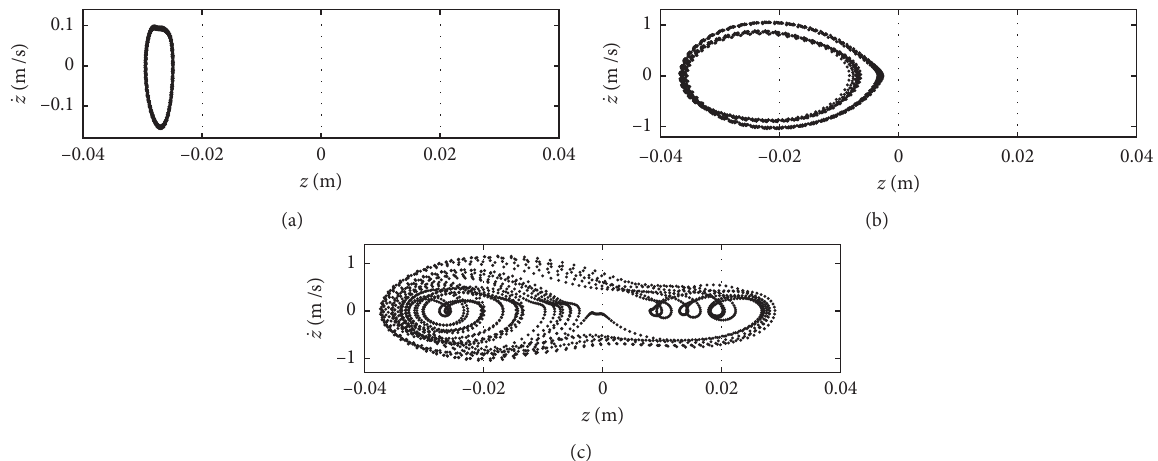
Figure 11: Phase diagrams of the response under harmonic excitation: (a) b